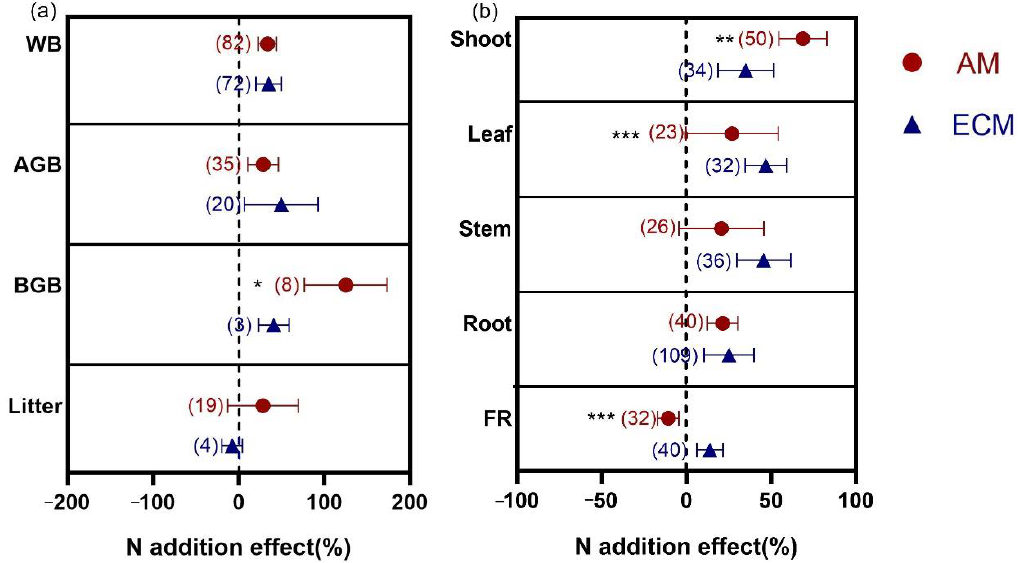
Figure 3. Effects of N addition on WB, AGB, BGB and litter biomass ( a ) and biomass of shoot, leaf, stem, root and FR ( b ) in AM and ECM woody plants. AM means arbuscular mycorrhizal type with typical AM structures. ECM means ectomycorrhiza type with typical ECM structures. The symbols represent the average of the 95% confidence intervals (CIs). The effect is considered to be significant when the 95% CI does not overlap with zero. The chi-square test was used to test the heterogeneity of all index effects between AM and ECM plants (*** p < 0.001, ** p < 0.01, and * p < 0.05). WB, whole plant biomass; AGB, aboveground biomass; BGB, belowground biomass; FR, fine root. The numbers in parentheses represent the sample size of observations.